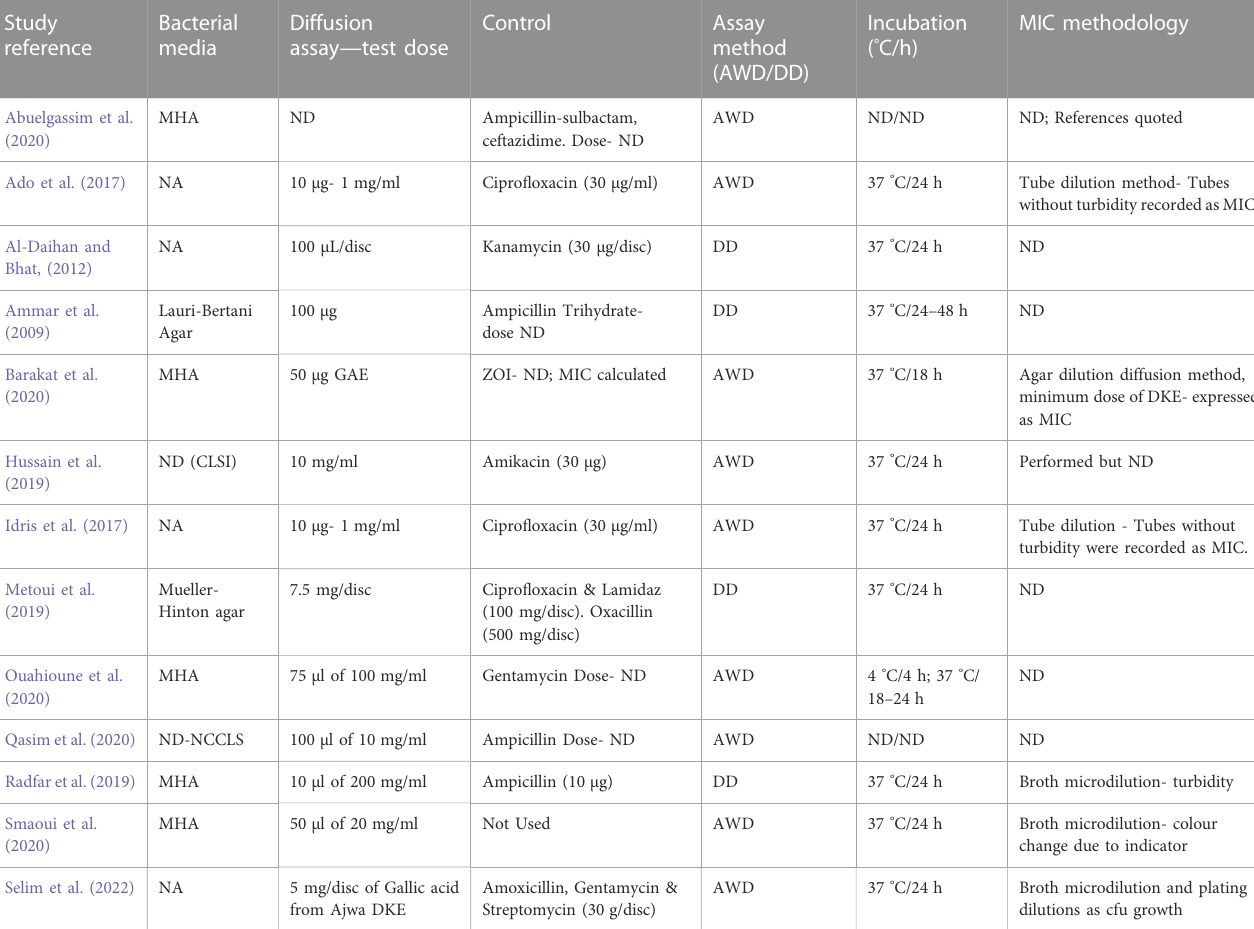
TABLE 3 Key parameters of antibacterial assays in included studies.